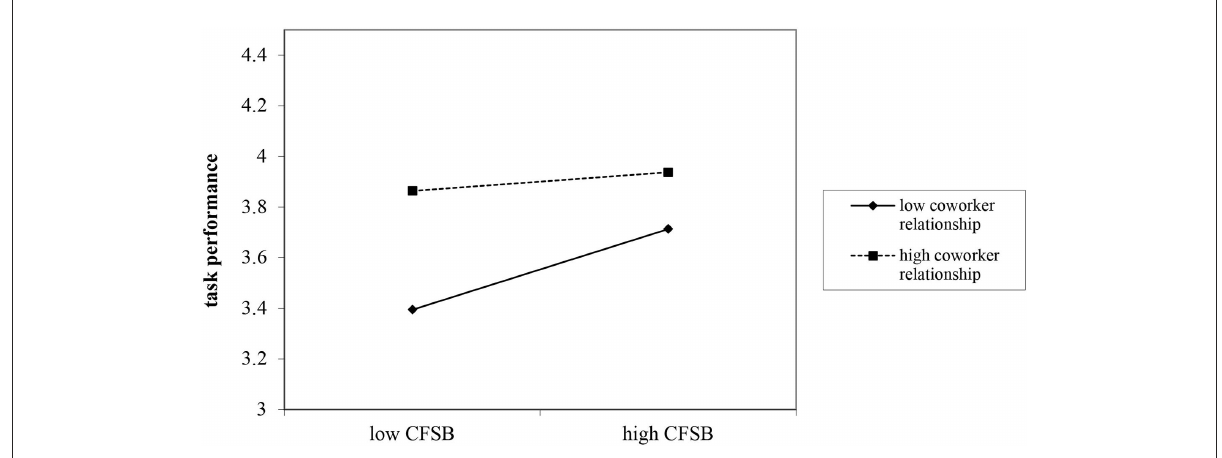
FIGURE2 The moderating role of coworker relationship on the coworker feedback-seeking behavior (CFSB) and task performance relationship.